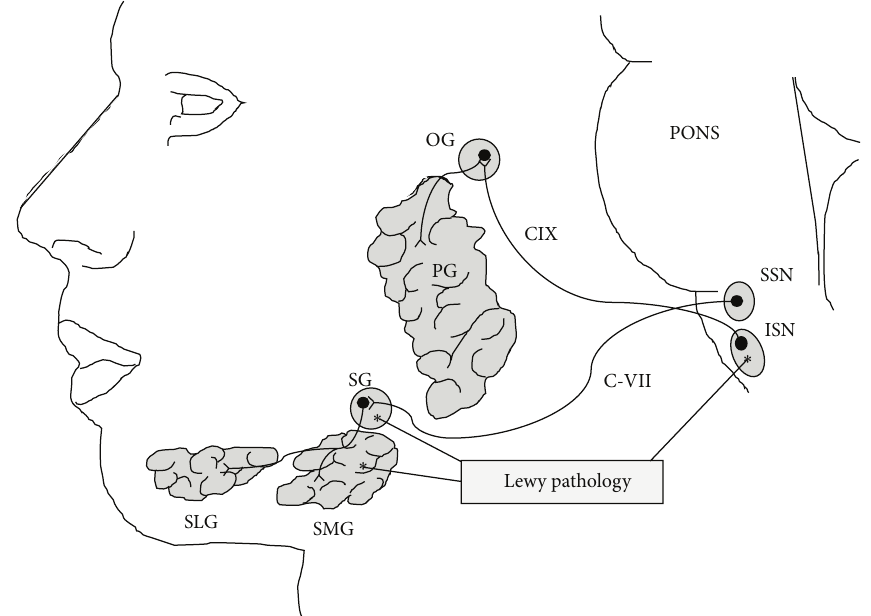
Figure 1: The preganglionic parasympathetic cell bodies responsible for innervation of the submandibular and sublingual glands are located in the superior salivary nucleus and terminate in the submandibular ganglion, from which postganglionic fibres reach the glands. The preganglionic cell bodies which innervated the parotid gland are located in the inferior sal nucleus and terminate in the otic ganglion. Lewy body pathology has been detected in the submandibular gland, submandibular ganglion, and inferior salivary nucleus. (C-VII, facial nerve; CIX, glossopharyngeal nerve; ISN, inferior salivatory nucleus; OG, otic ganglion; PG, parotid gland; SG, submandibular ganglion; SLG, sublingual gland; SMG, submandibular gland; SSN, superior salivatory